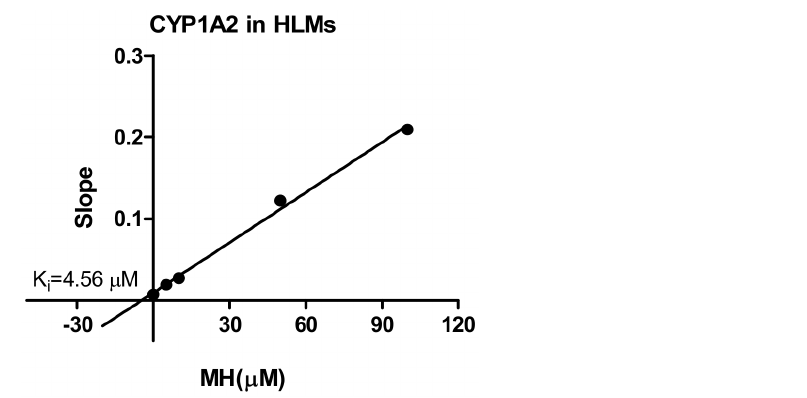
Figure 6. Secondary plot of CYP1A2 activity using the slopes of the primary Lineweaver-Burk plots versus concentrations of MH . Note: The effects of MH on the metabolism of phenacetin O-deethylation in human liver microsomes. Each point represents the mean of triplicate